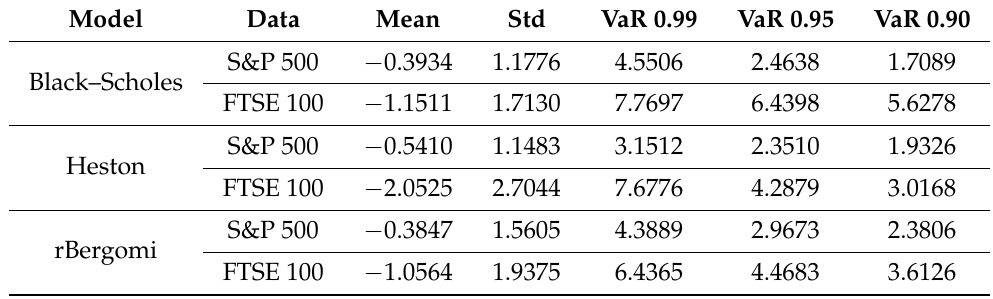
Table 6. Hedging performance